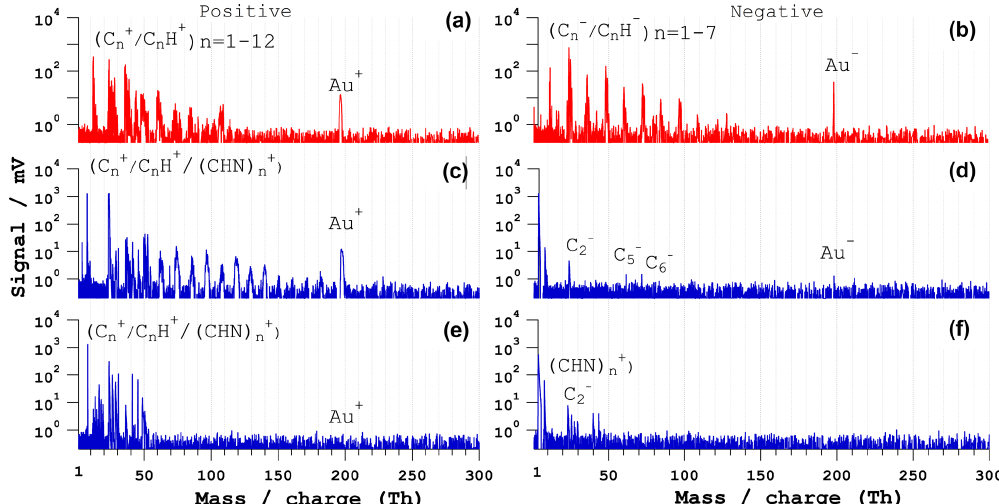
Figure 8. Bipolar mass spectra of Au-PAH core-shell particles. (a, b) Typical ns-LAAPTOF spectra and (c, d) fs-LAAPTOF ( λ = 800nm) spectrum that contains both gold and PAH signals, (e, f) fs-LAAPTOF ( λ = 800nm) spectrum without gold signal. The pulse energy is 4mJ for the ns laser and 3.2mJ for the fs